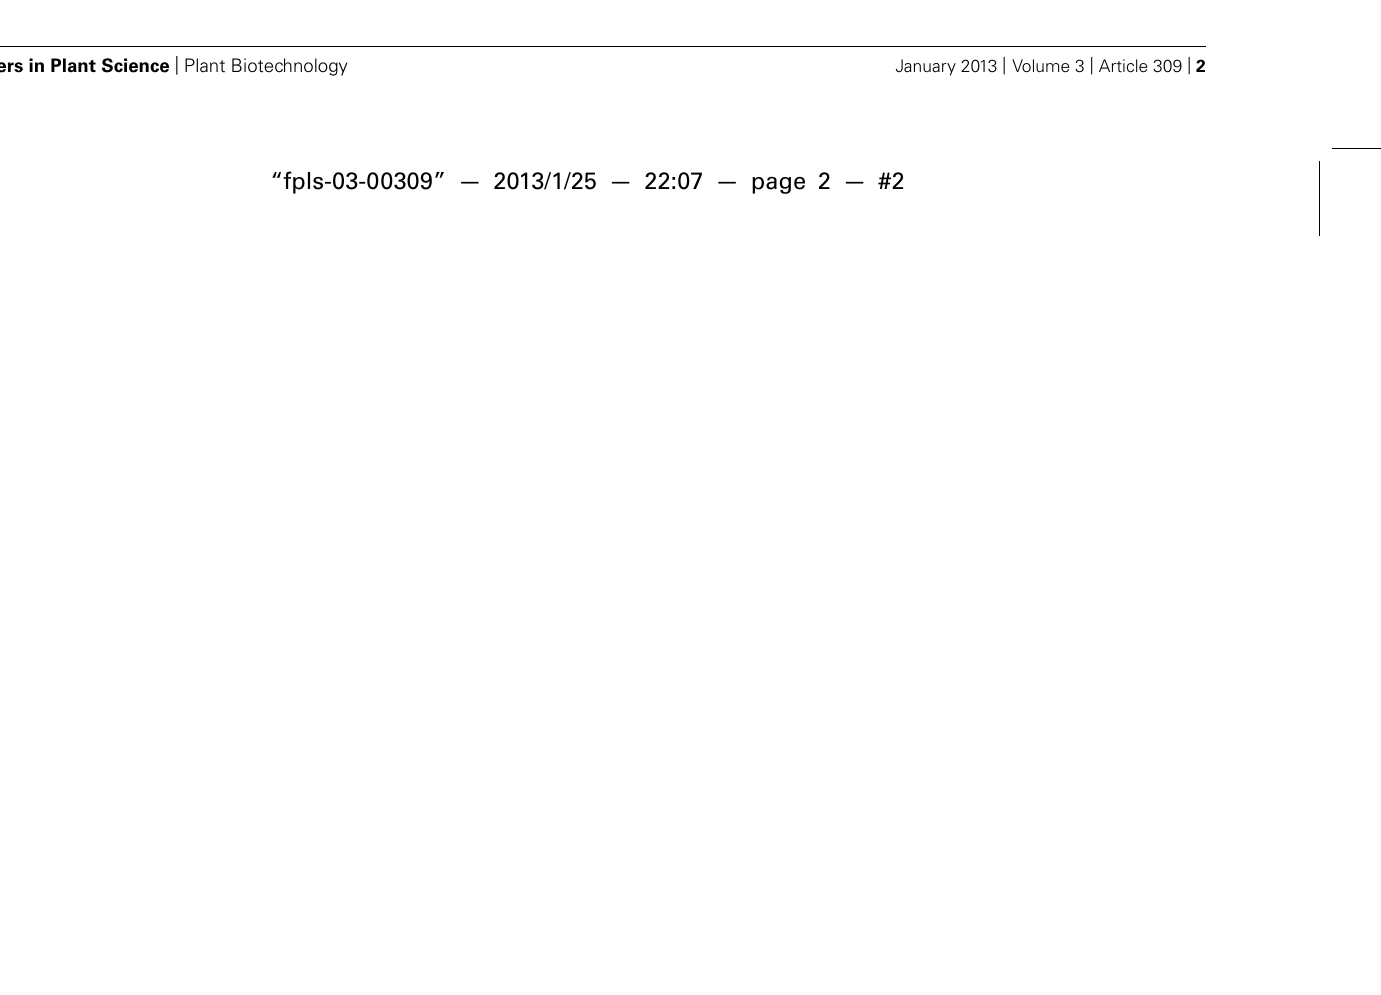
CESA velocity and hyperaccumulation at the plasma membrane. Finally, Morlin and cobtorin (Group 3) induce the plasma membrane localized CESA to move with aberrant trajectory and cause reduced CESA movement. For each example, the scale bar = 10 μ m (images courtesy of Seth